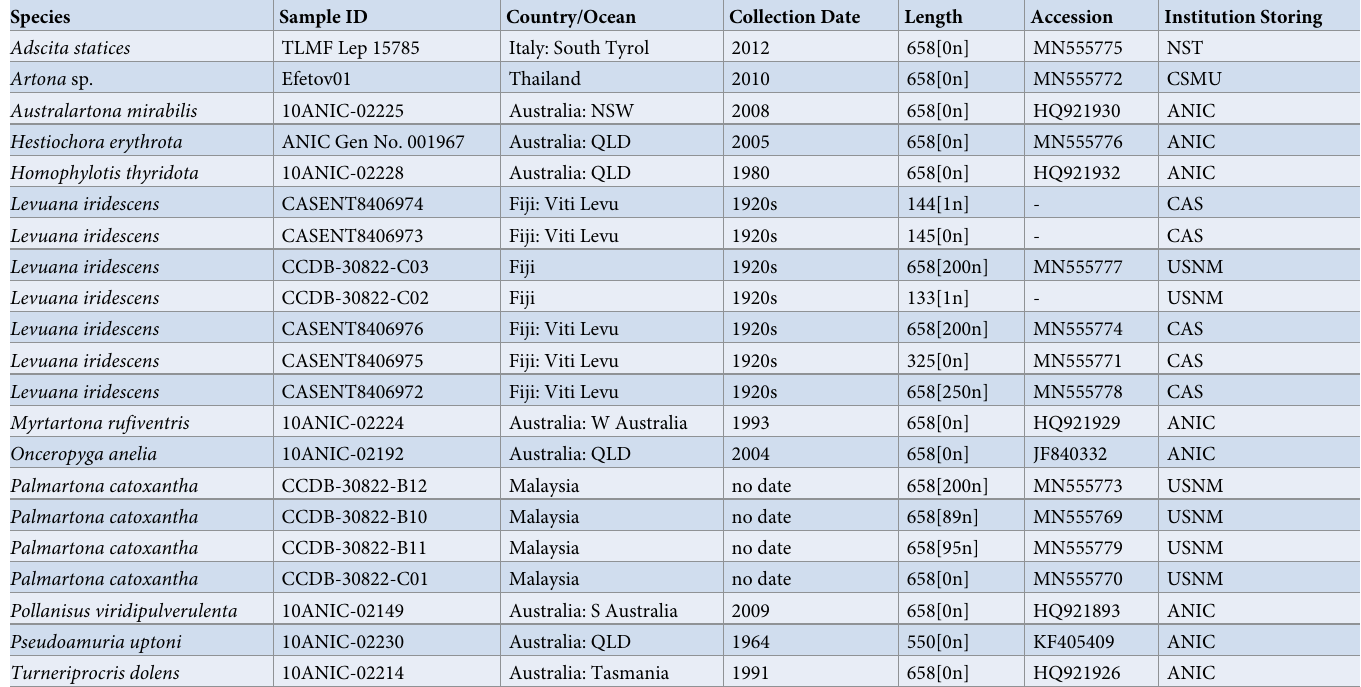
Table 1. DNA barcoded specimens and their Genbank